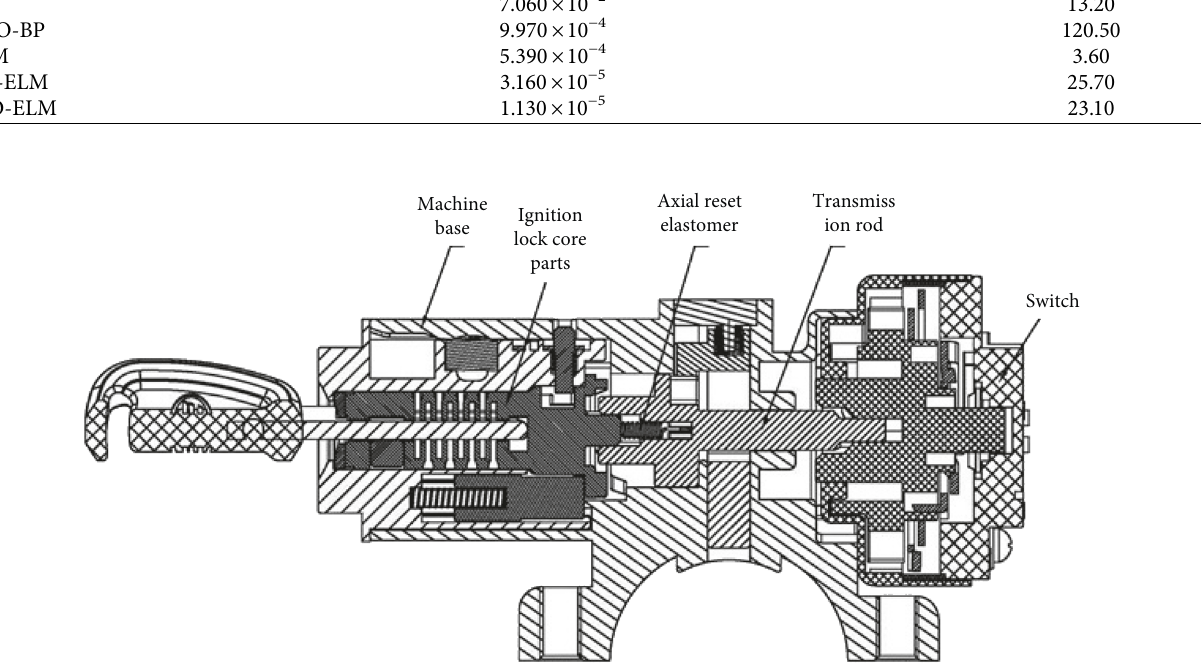
Figure 10: Automotive electrical switch.